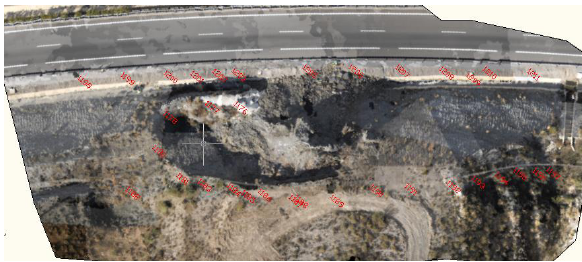
Figure 14. Location of the 31 target points used as check points for the error estimation